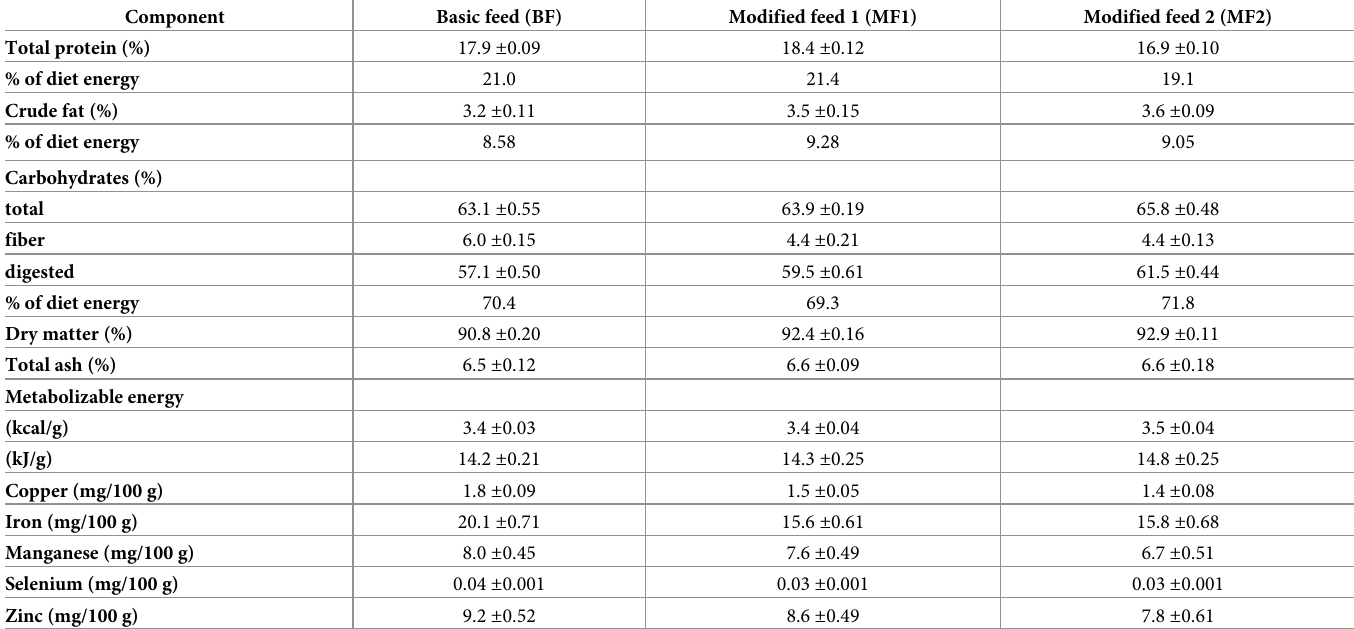
Table 2. Chemical composition of